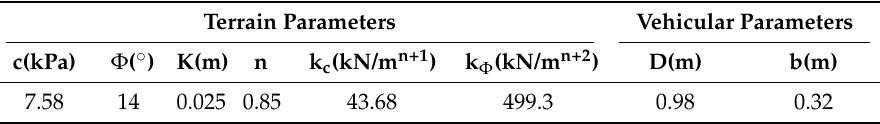
Table 5. Parameters involved in the traditional semi-empirical model.